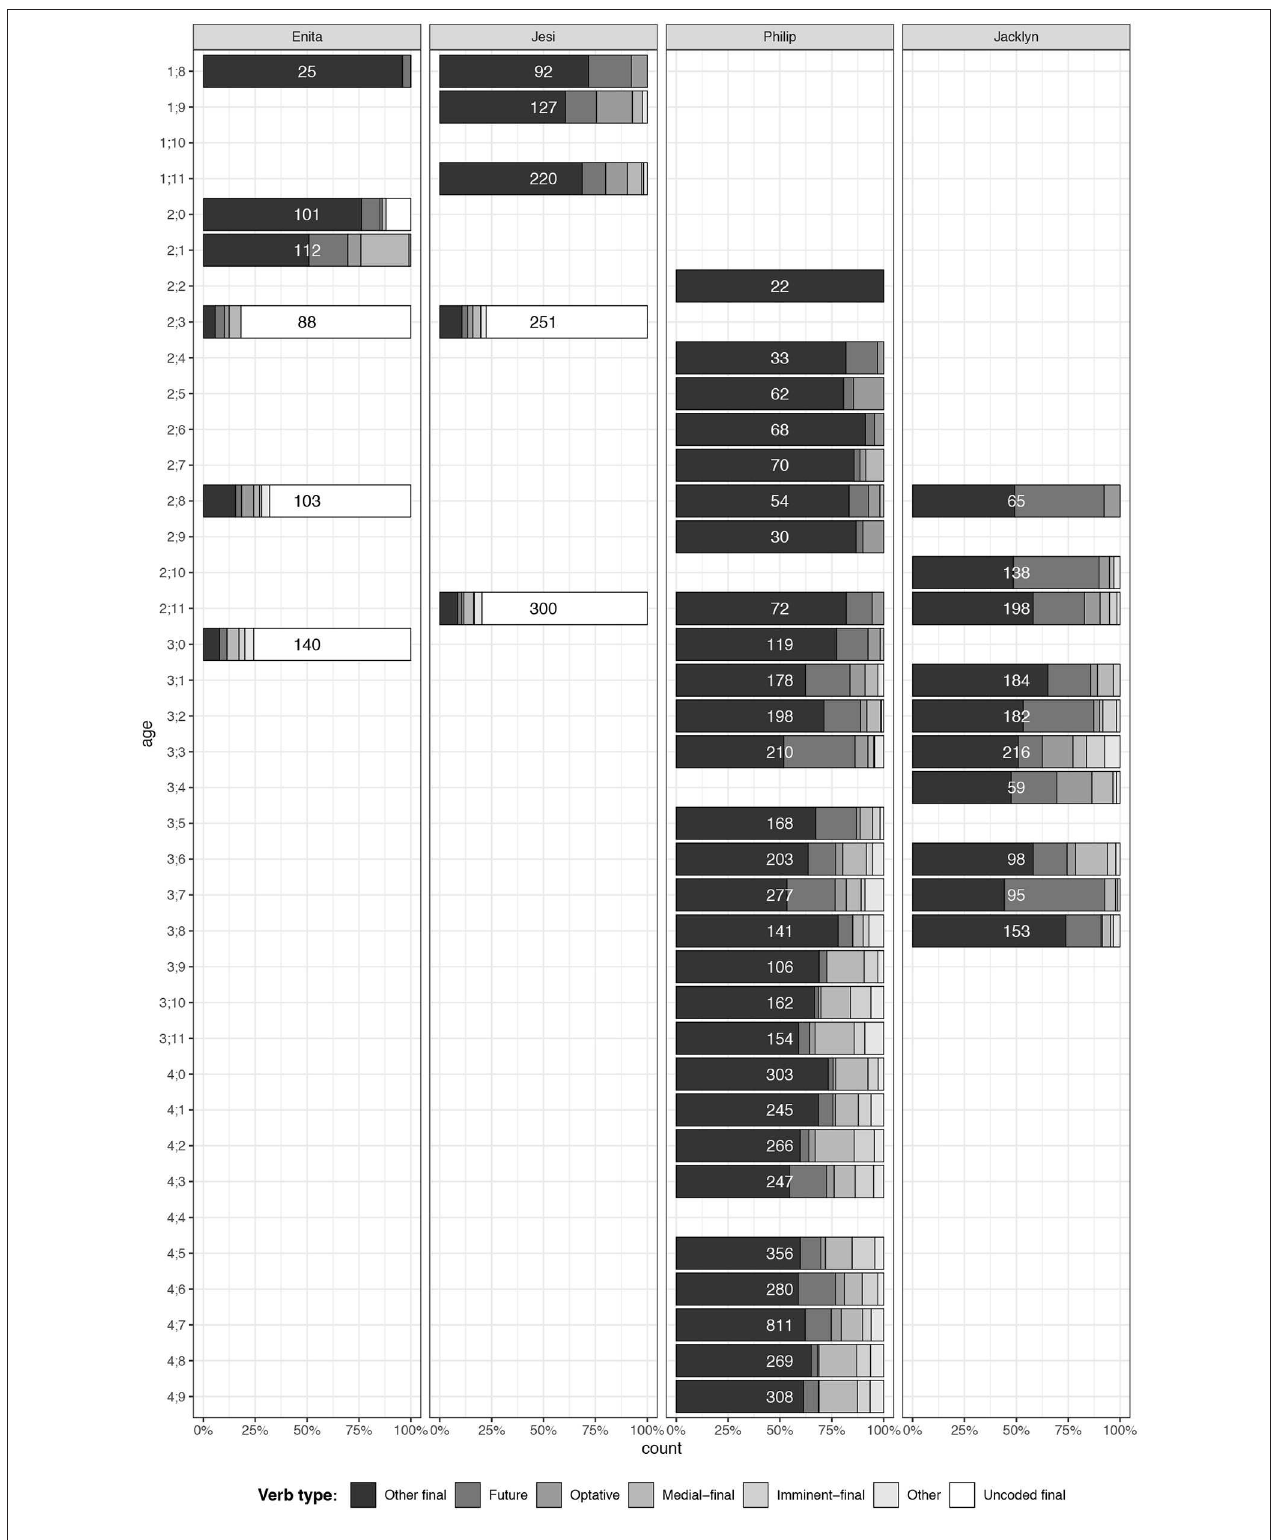
FIGURE 4 | Incidence in the children’s speech of common clause chain types.